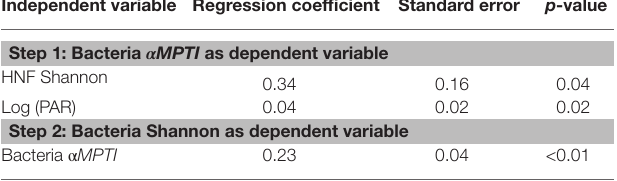
TABLE 1 | Results of generalized linear mixed effect model (GLMM) after backward selection to test for top-down control mechanisms. Independent variable Regression coefficient Standard error p -value